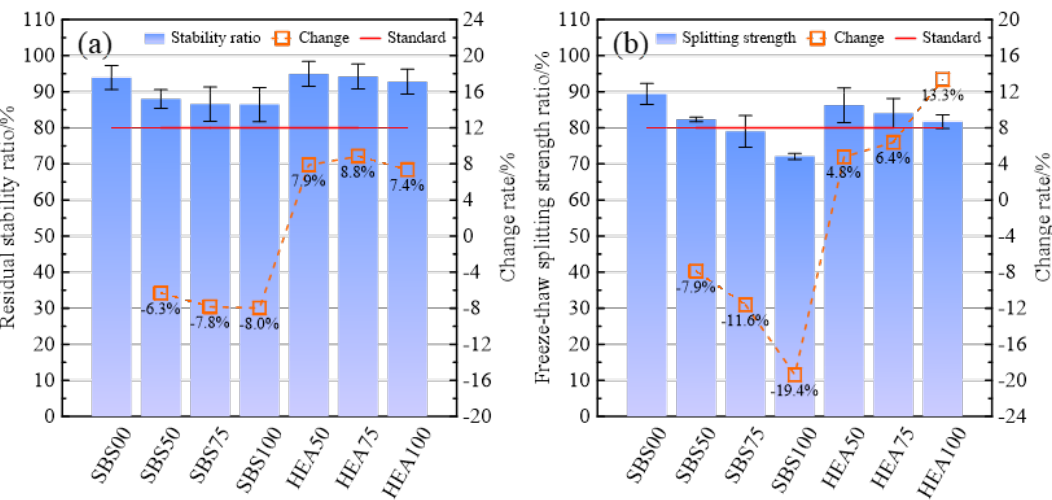
Figure 4. Moisture resistance performance of SSAM. ( a ) Residual stability; ( b ) splitting strength Figure 1. The agent interacts with the environment. When the agent observes the environment’s state, the agent chooses action from the list of action pulled by maximum Q-value requirement which is the target of RL algorithms. And then, agent get the reward which depends on the action execution. Environment’s state changes to new state, the next step starts.